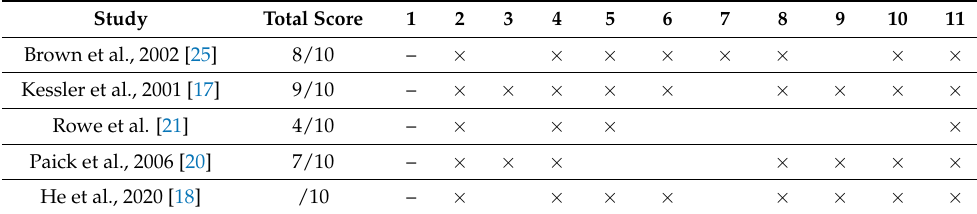
Table 2. PEDro score for methodological quality assessment of five studies.